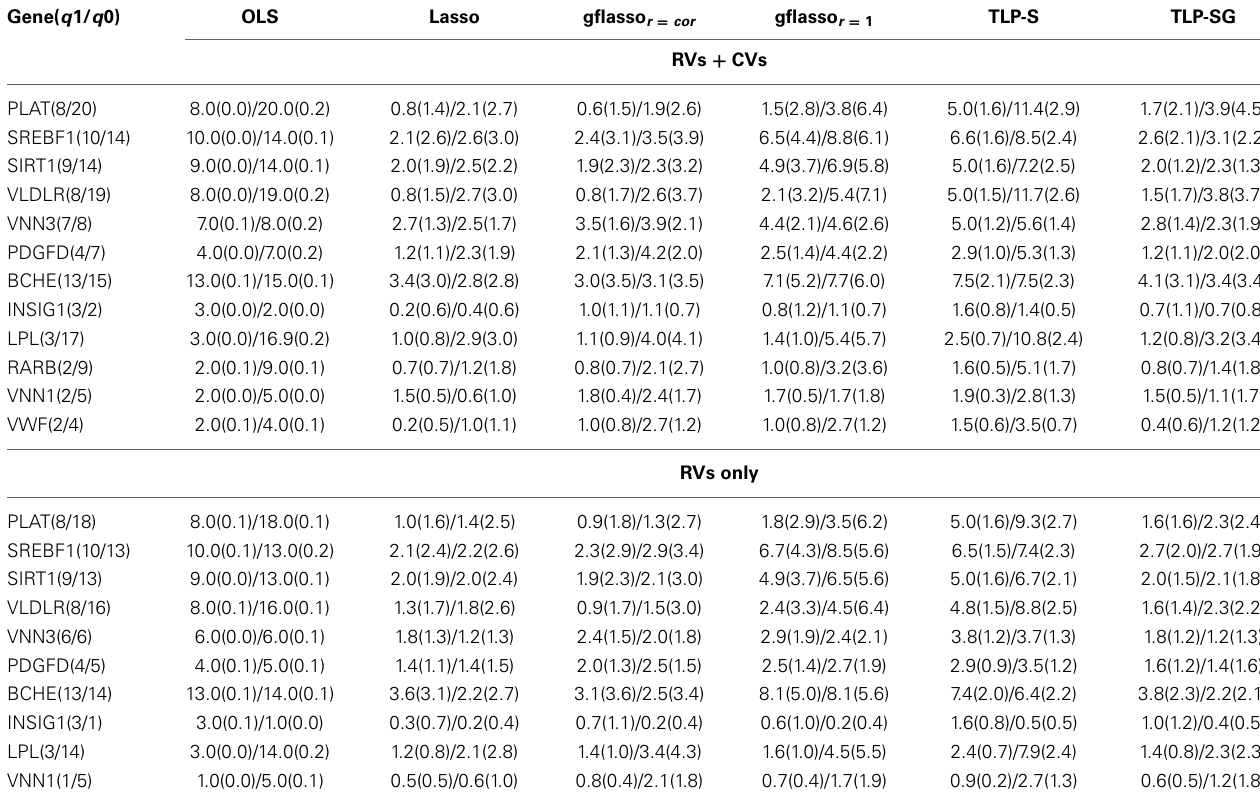
Table 8 | Mean numbers of TP(sd)/FP(sd) in the GAW17 data, where q 1 and q 0 denote the numbers of the causal and non-causal variants in each